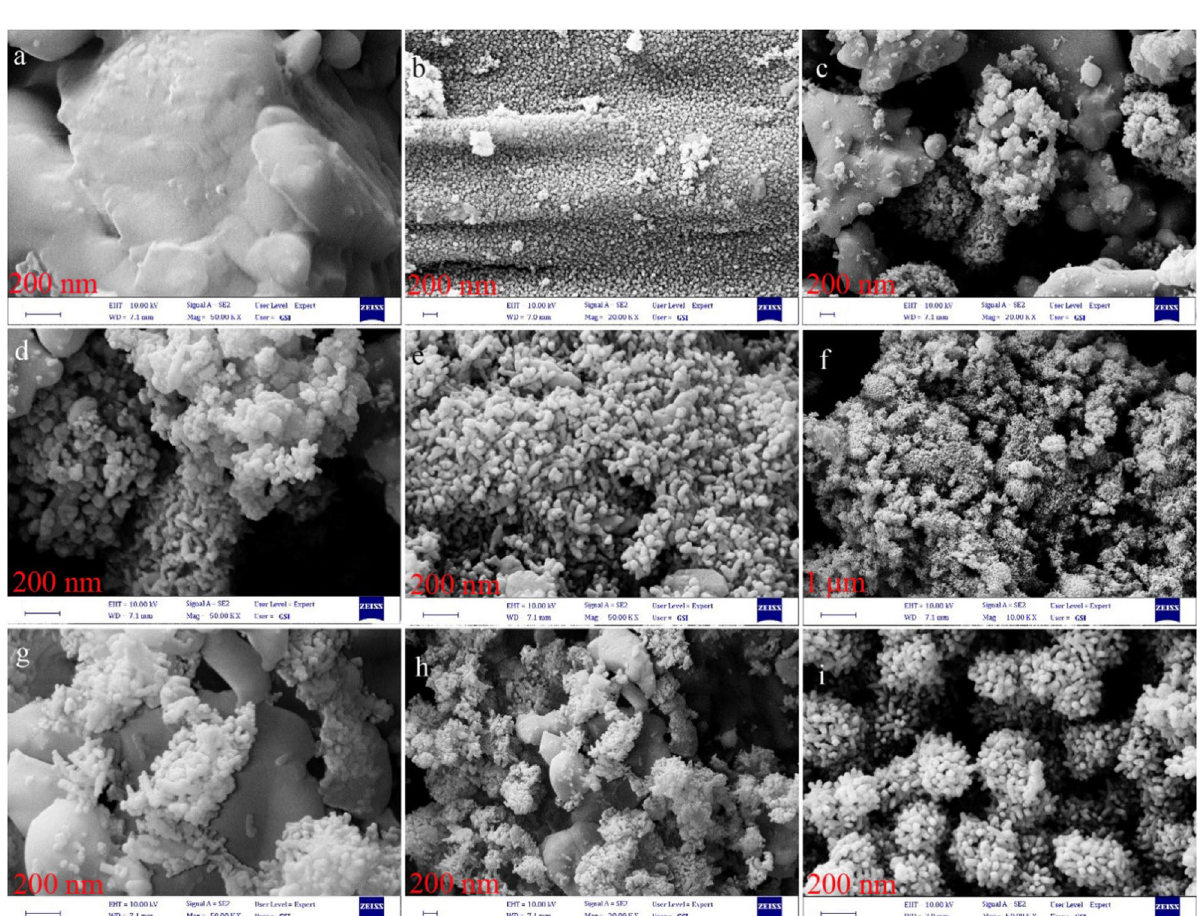
Figure 6. SEM images of ( a , b ) BaSO 4 –BaTiO 3 , ( c , d ) Cu–BaTiO 3 , ( e , f ) Fe–BaTiO 3 , ( g , h ) S–BaTiO 3 , and ( i )